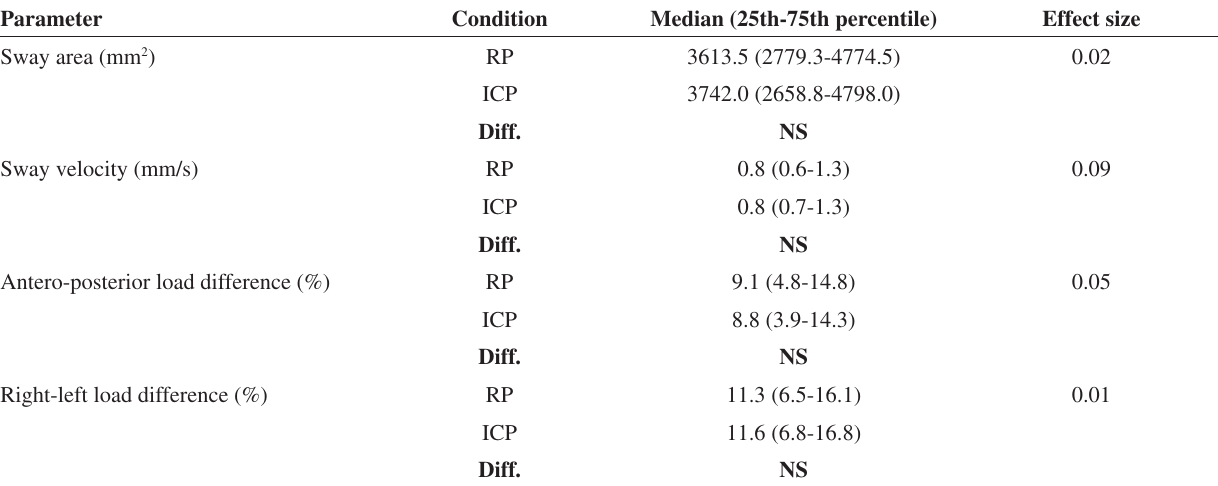
RP = rest position; ICP = intercuspidal position; Diff. = difference among the experimental conditions; NS = difference not statistically